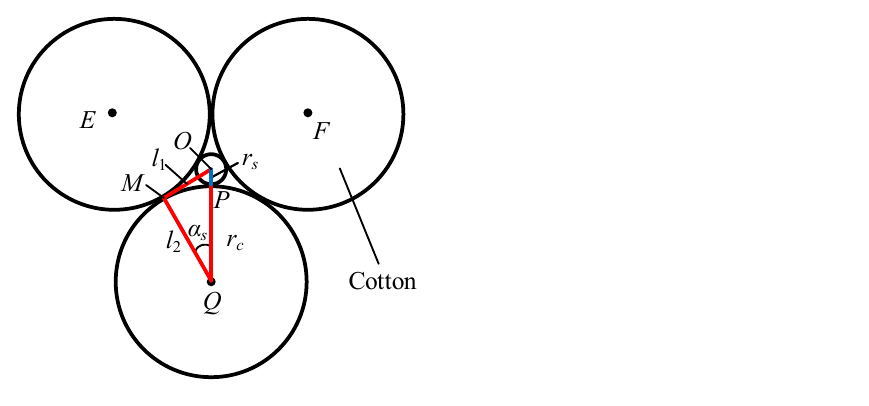
Figure 7. Spatial distribution diagram of the spindle and the cotton during cotton picking.